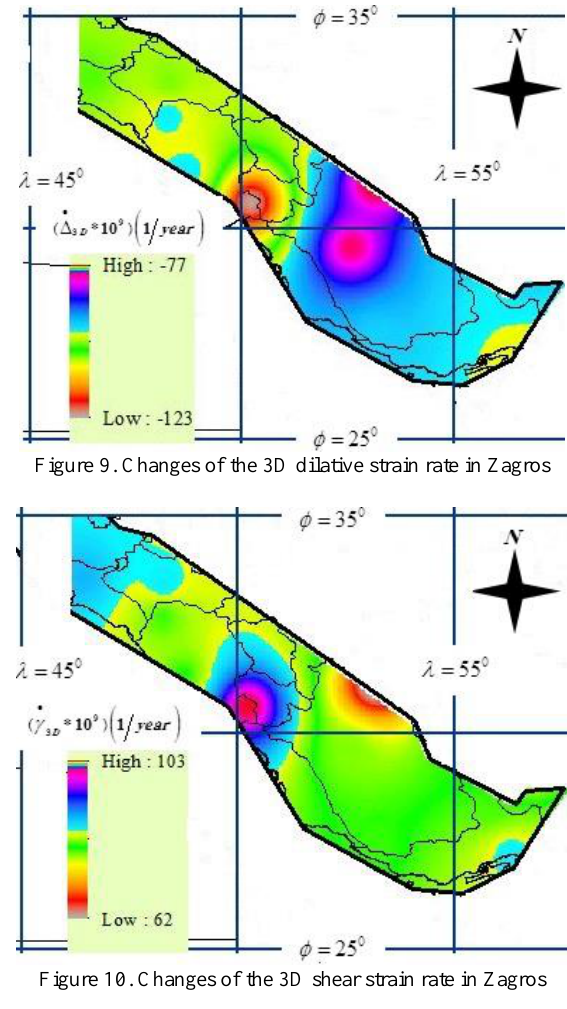
Figure 8. Changes of the 2D shear strain rate in Zagros The 3D dilative and shear strain rates ( 3 D describe the 3D volumetric changes and the absolute 3D deformation in Zagros, respectively.